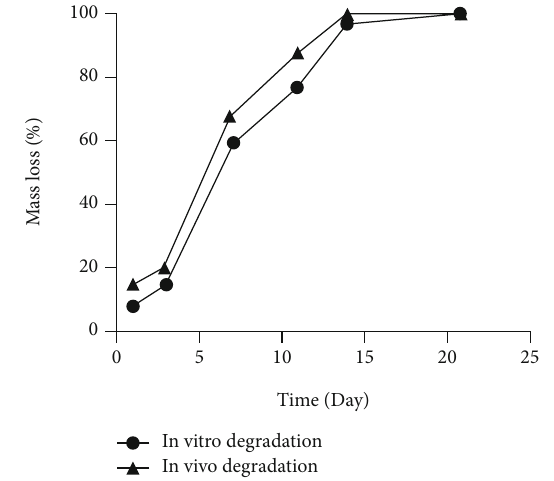
Figure 3: Degradation rate of cellulose composite hemostatic materials in rats and phosphate-bu ff ered